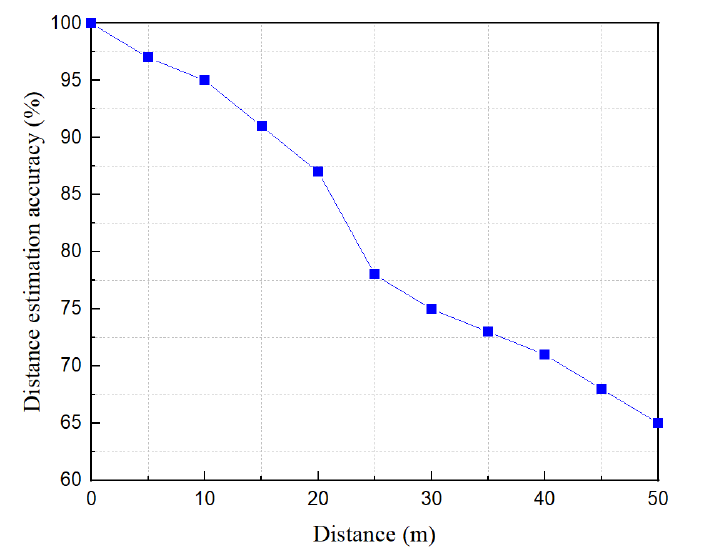
Figure 11. Estimation of distance measurement accuracy.